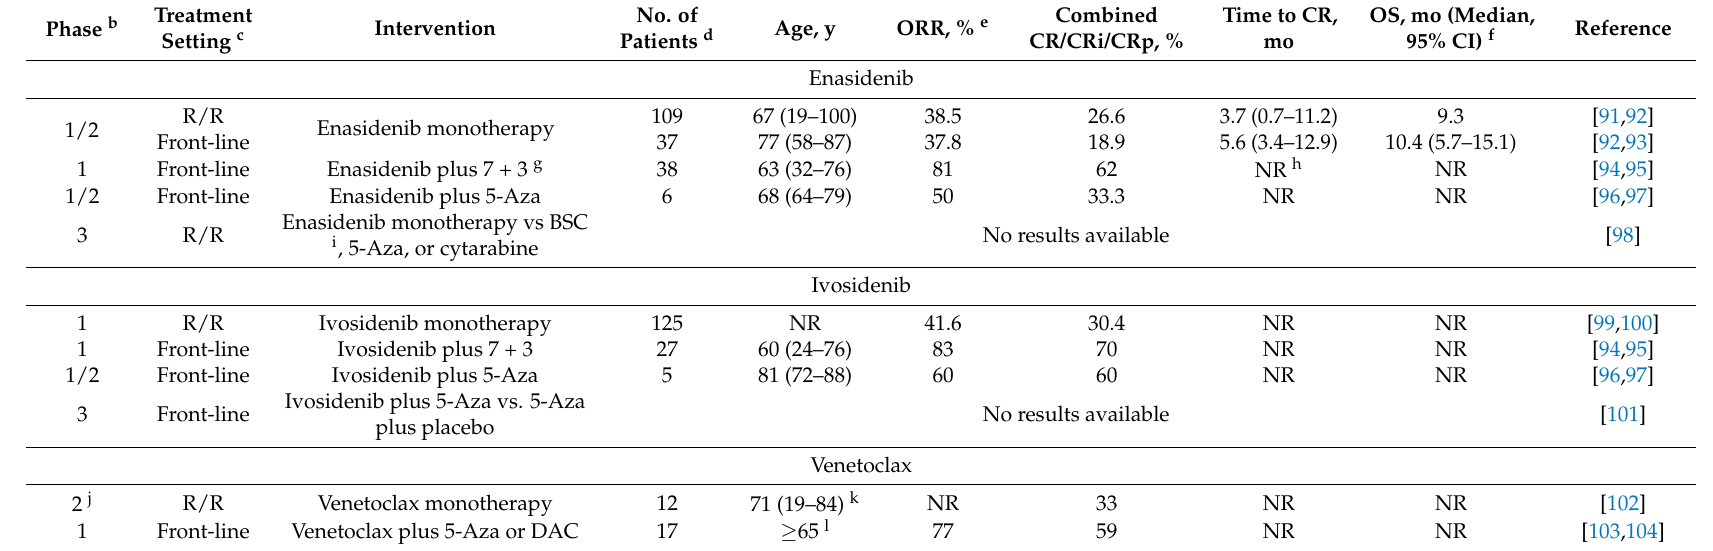
Table 1. Clinical trials for targeted therapies in patients with mIDH AML a